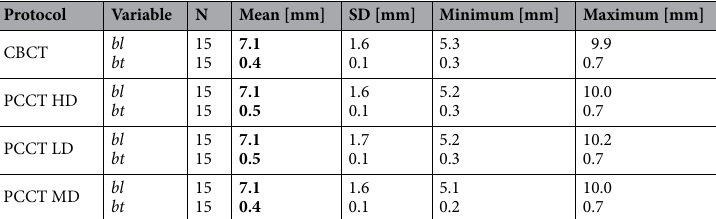
Table 4. Means of bl and bt . N number of measurements, SD standard